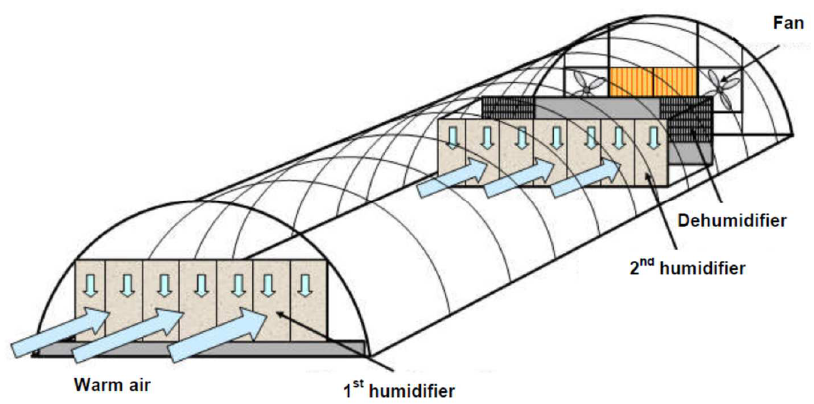
Figure 23. Illustration of the GH. Reproduced with permission from J. S. Perret, A. M. Al-Ismaili, S. S. Sablani, Biosystems Engineering Journal, published by Elsevier, 2005